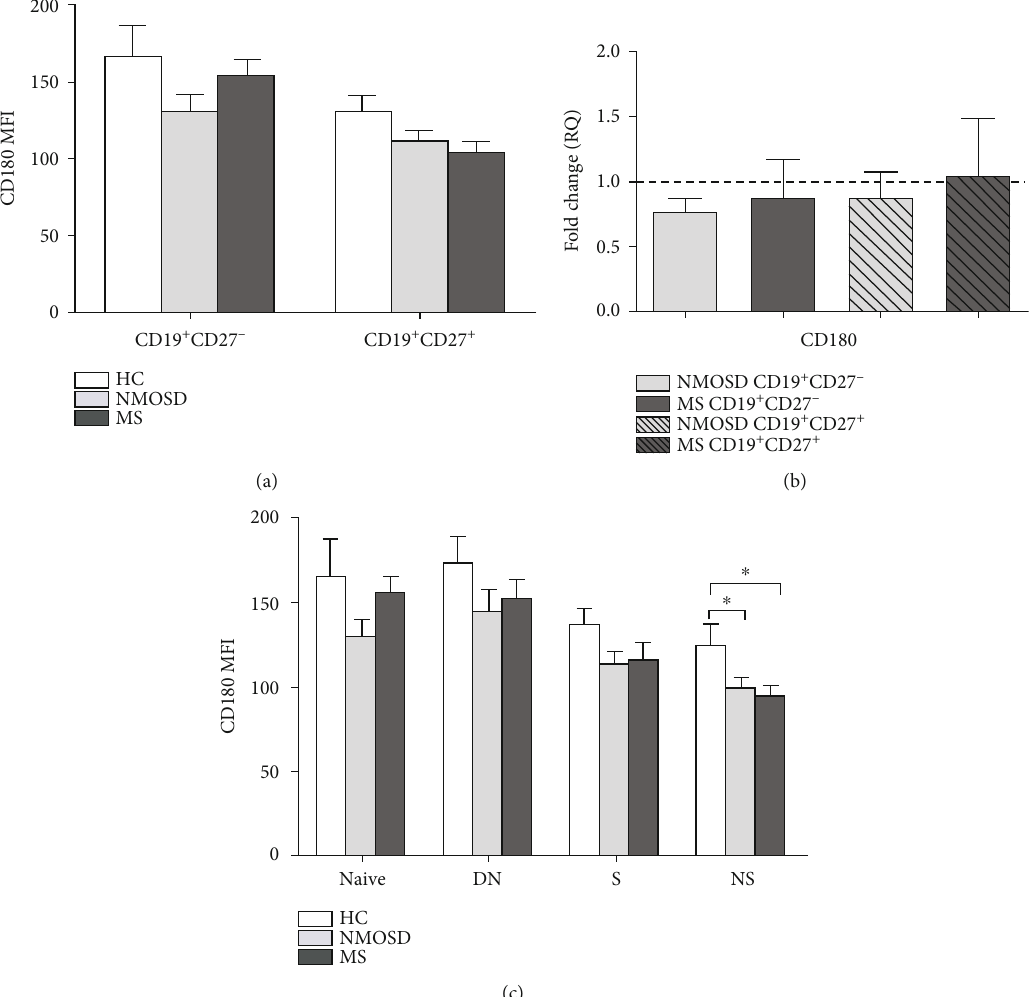
Figure 2: Analysis of CD180 expression in B cell subsets of neuromyelitis optica spectrum disorder (NMOSD) and multiple sclerosis (MS) patients. (a) Flow cytometric analysis of CD180 expression in naïve (CD19 + CD27 - ) and memory (CD19 + CD27 + ) B cells in peripheral blood of NMOSD ( n = 9 ), MS ( n = 7 ), and healthy controls (HC) ( n = 5 ). (b) CD180 mRNA expression in B cells of NMOSD ( n = 5 ) and MS ( n = 5 ) patients compared to HC ( n = 5 ). Gene expression was normalized to HC, and the horizontal line (value 1) represents the expression of control samples. Changes in gene expression are shown as relative quanti fi cation (RQ) values. (c) Flow cytometric analysis of CD180 expression in CD19 + CD27 - IgD + naïve, CD19 + CD27 - IgD - double-negative (DN), CD19 + CD27 + IgD - switched (S) memory, and CD19 + CD27 + IgD + nonswitched (NS) memory B cells in peripheral blood of NMOSD ( n = 9 ), MS ( n = 7 ), and healthy controls (HC) ( n = 5 ). Data are shown as mean ± standard errorof the mean ð SEM Þ ; ∗ p < 0 : 05